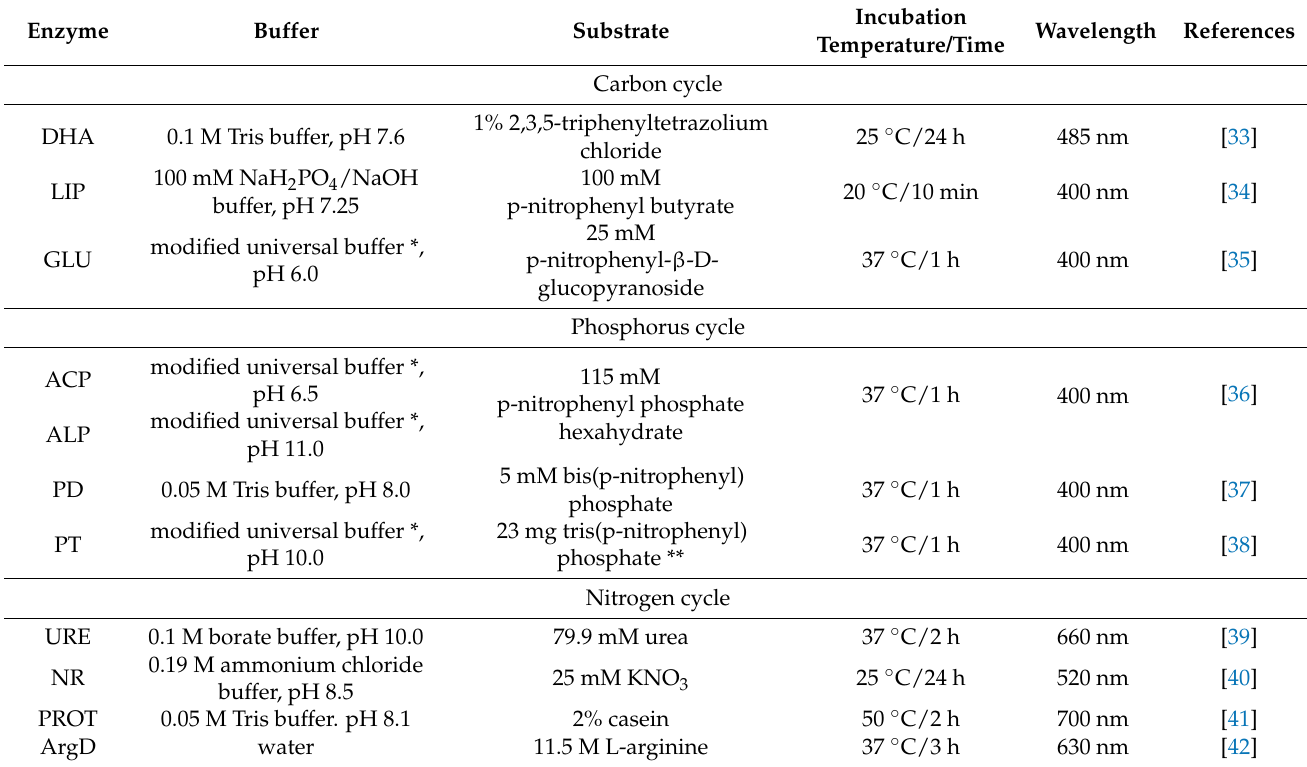
Table 1. Details of the spectrophotometric methods used for determining soil enzyme